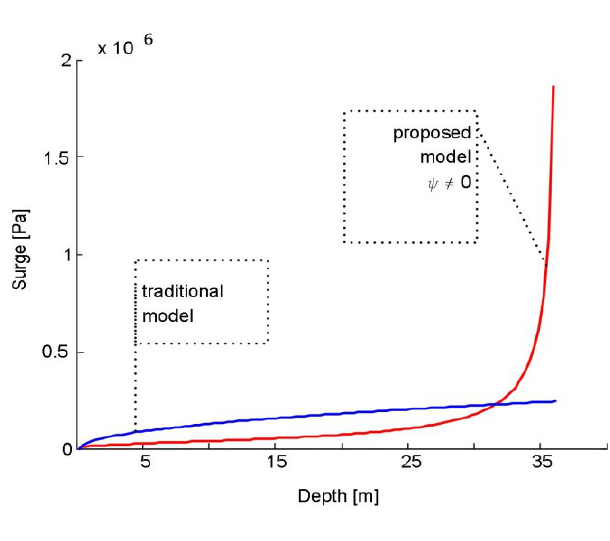
Fig. 13: Comparison between Surge Values Obtained If the value of Surge pressure is greater than the real one, can cause damage to the formation, therefore, the operating window that contains the pressures and speeds, ideal for safe operation of the maneuvers, has maximum and minimum boundary. If the calculated pressure value is incorrect, hydrostatic fluid will be injected